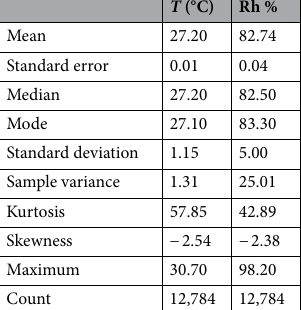
Table 1. Simple statistical analysis for the measured air temperature (T) and relative humidity (Rh).